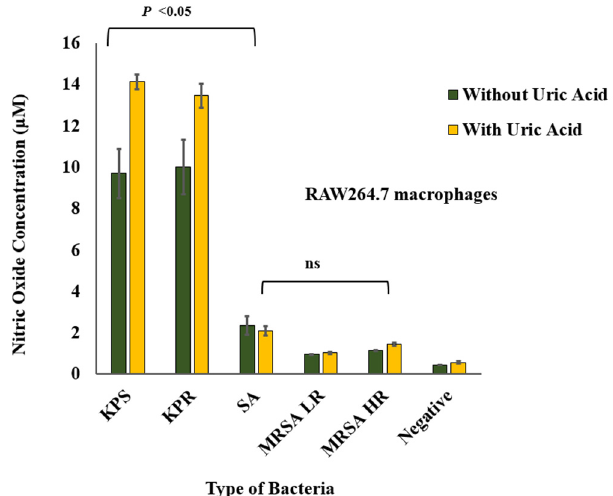
Figure 6. Nitric oxide release from infected murine macrophages in presence and absence of uric acid. Murine RAW264.7 macrophages were infected with formalin-fixed bacteria in presence and absence of soluble uric acid (19 mg / dL) and incubated overnight. Nitric oxide release in the supernatants was quantitated using the Griess method. These data represent the mean of six independent experiments with bars showing the standard error of the mean. KPS: K. pneumoniae sensitive to antibiotics; KPR: K. pneumoniae resistant to antibiotics; SA: S. aureus ; MRSA LR: methicillin-resistant S. aureus with low level of resistance; MRSA HR: methicillin-resistant S. aureus with high level of resistance; UA: uric acid; ns: not significant. p value < 0.05 are